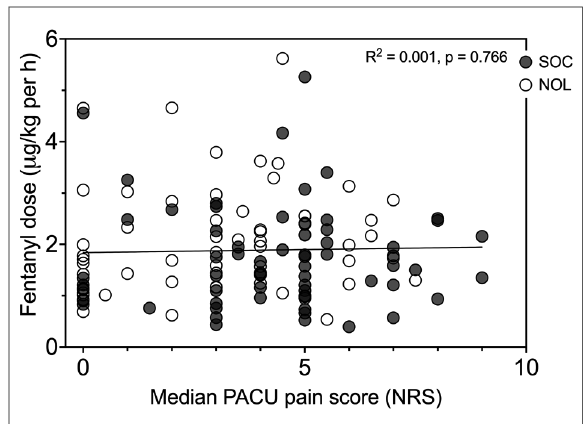
FIGURE 4 Intraoperative fentanyl dose vs. median pain score in the PACU for Nociception Level (NOL)-guided patients (open symbols) and standard of care patients (SOC, closed symbols). Each dot is one patient. The line is the linear regression curve of the full data set. Pearson correlation: complete data set r 2 =0.001, p =0.766, NOL- guided patients r 2 =0.022, p =0.246, and SOC patients r 2 =0.000, p